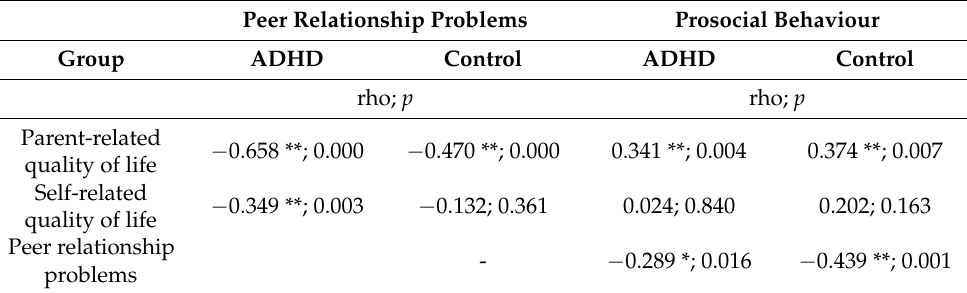
Table 5. Correlation between QoL and both peer problems and prosocial behaviour in the control and the ADHD